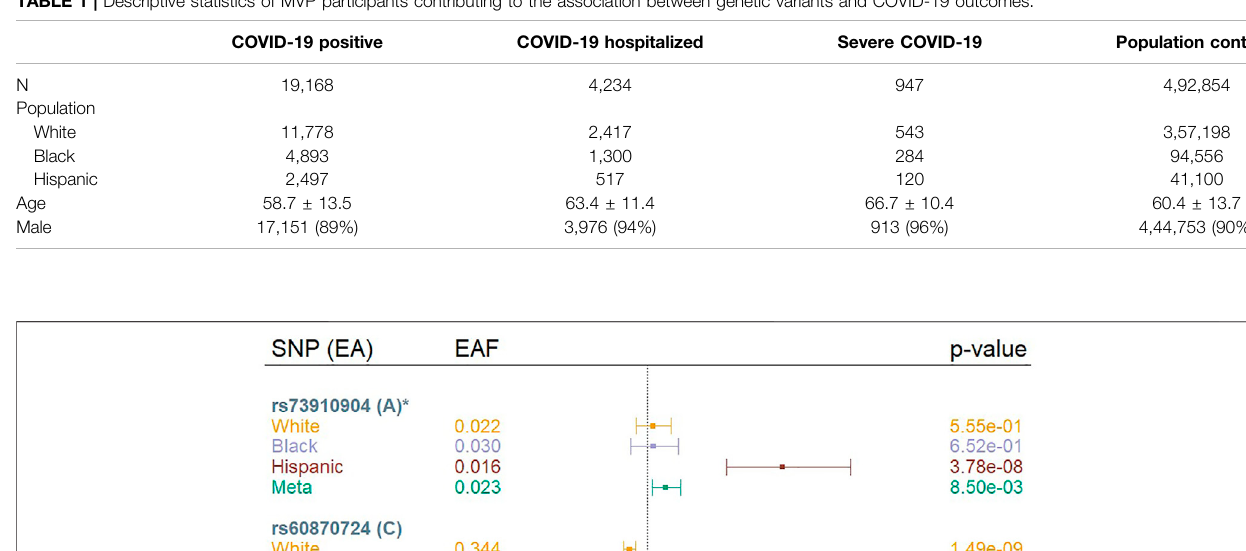
Frontiers in Genetics |